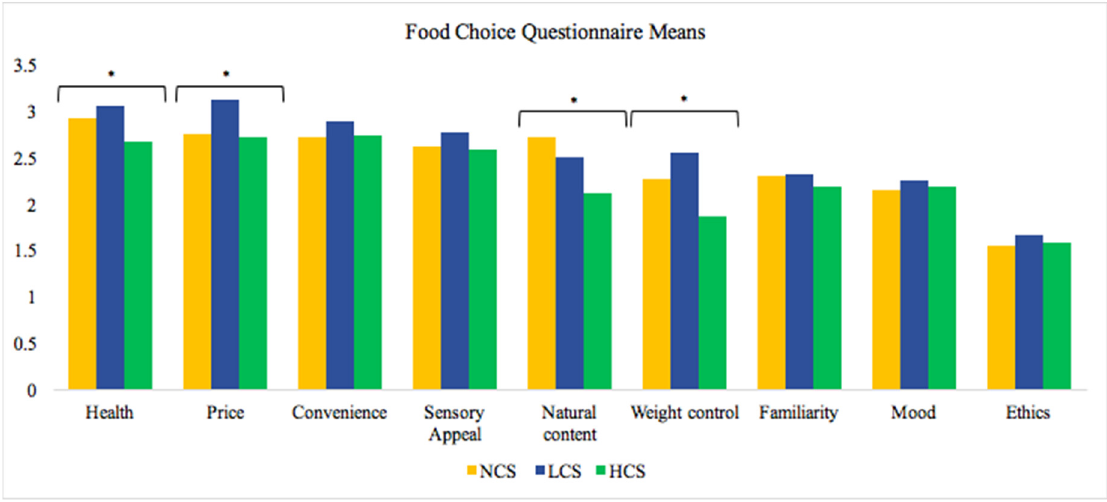
Figure 1. Food choice questionnaire results. NCS—noncontact sports, LCS—low contact sport, HCS—high contact sport. Note: * p < 0.05 represents a significant difference between groups.